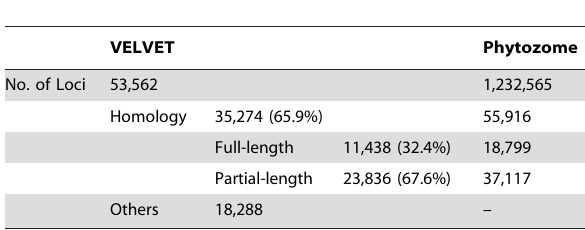
Table 4. Full-length ratio of the assembled cabbage